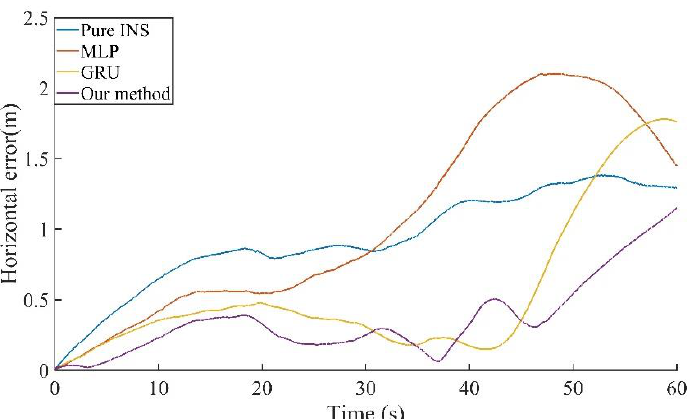
Figure 10. The horizontal position error result of 60 s outage of Experiment 1.